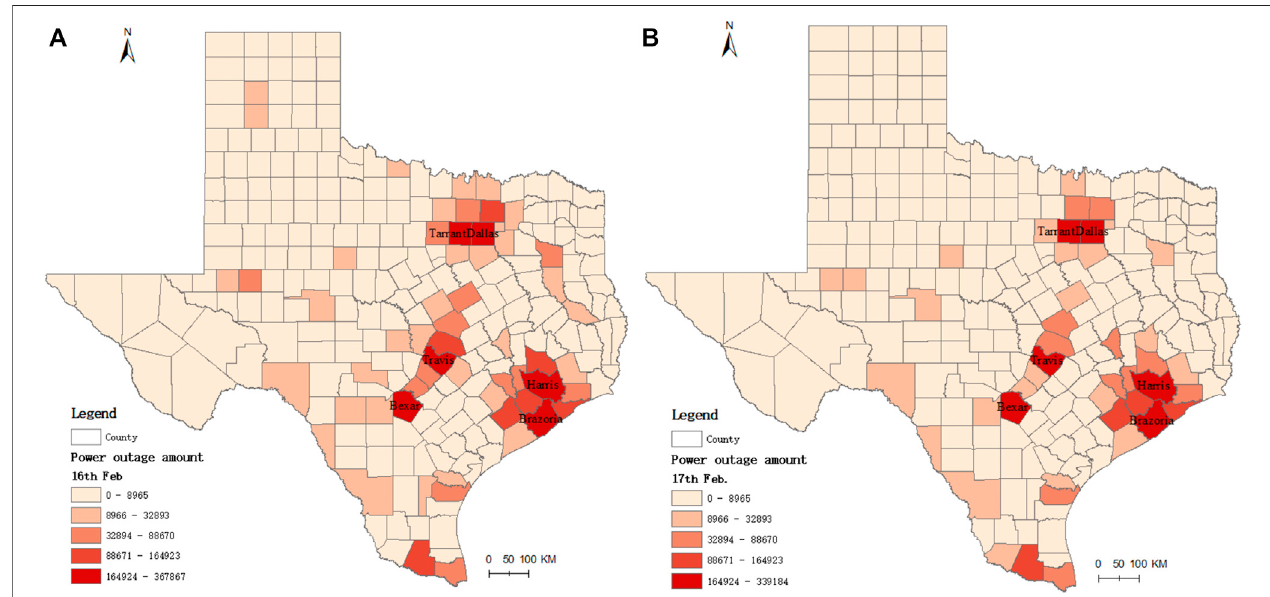
FIGURE 5 | Power outage amount in Texas on (A) 16th February and (B) 17th February, 2021.